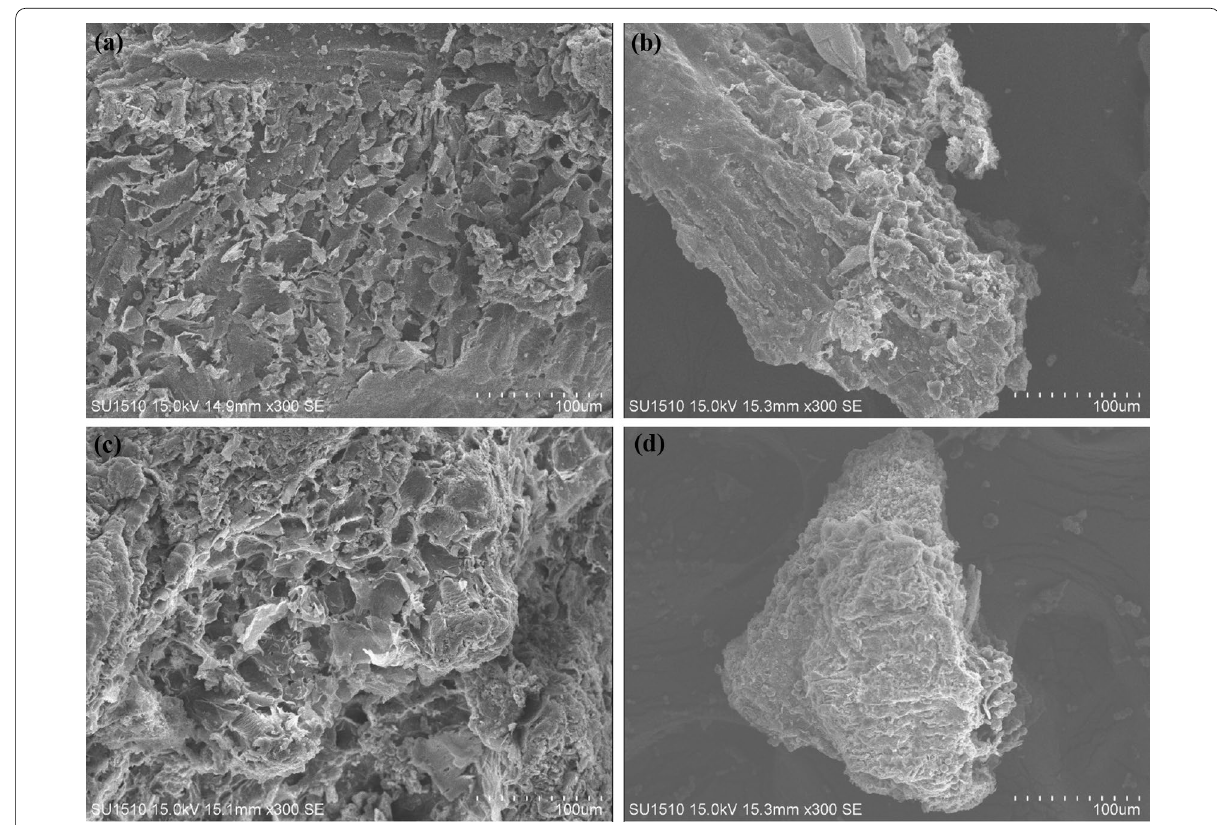
Fig. 4 SEM images of a rice husk; b sample RHH; c sample RHHK0.6 and d sample